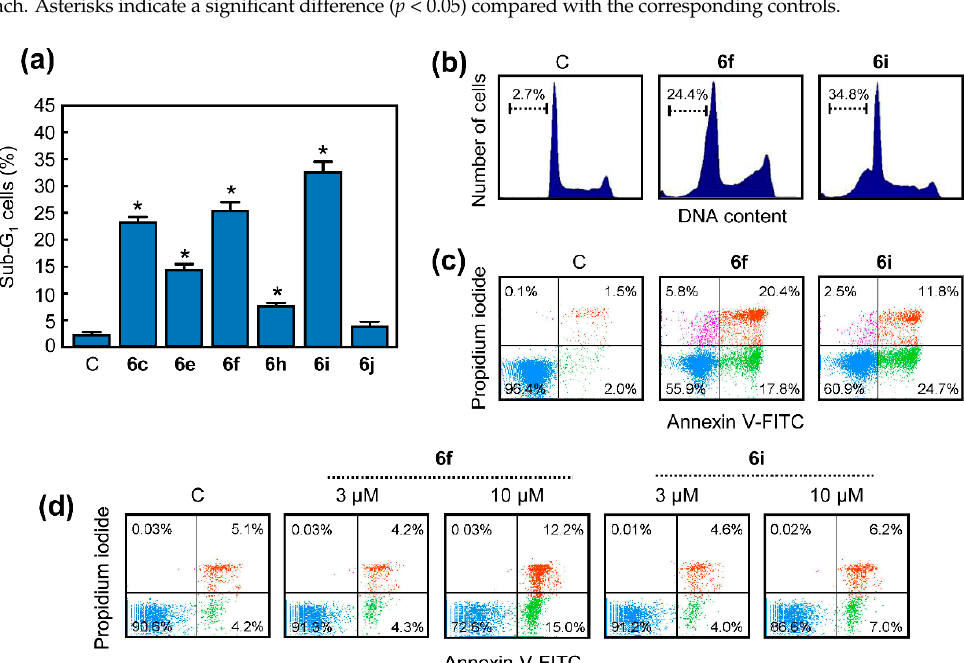
Cells were cultured with 10 µM of the indicated compounds for 24 h and the cell cycle phase distri- butions were determined by flow cytometry. The values are means ± S.E. of two independent ex- periments with three determinations in each. Asterisks indicate a significant difference ( p < 0.05) compared with the corresponding controls.